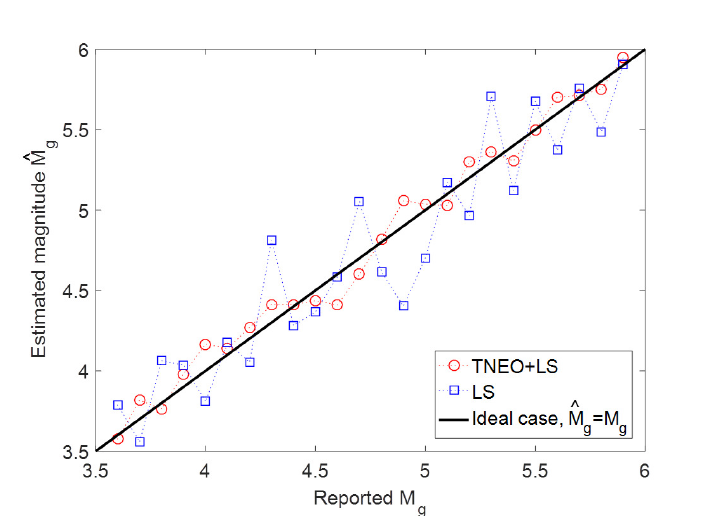
Figure 7. Average magnitude comparison between the TNEO model and general